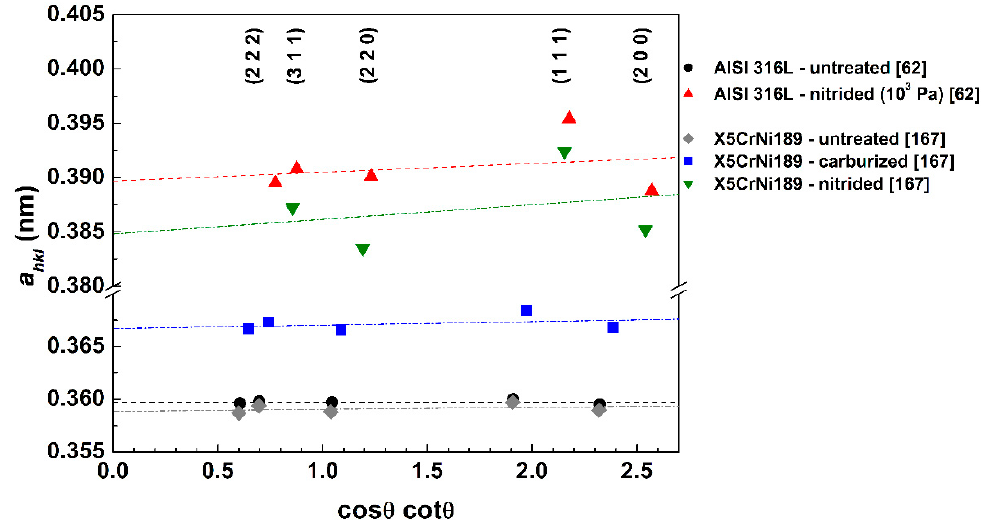
Figure 7. Plot of lattice parameters a hkl vs. cos θ cot θ for AISI 316L samples, untreated and nitrided at 430 °C, 10 3 Pa, 5 h (ref. [62]) and for X5CrNi189 samples, untreated and subjected to PI 3 nitriding and carburizing (ref. [167]).